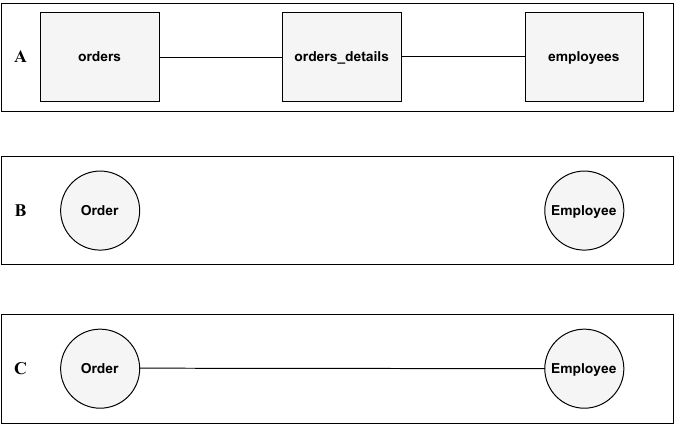
Figure 2. AMANDA workflow. ( A ) query tables, ( B ) create nodes in graph and ( C ) make relationships between nodes. orders_details is an associative table; it is converted into an edge in the graph. Through the schema.json file, the middleware is aware of which data must be